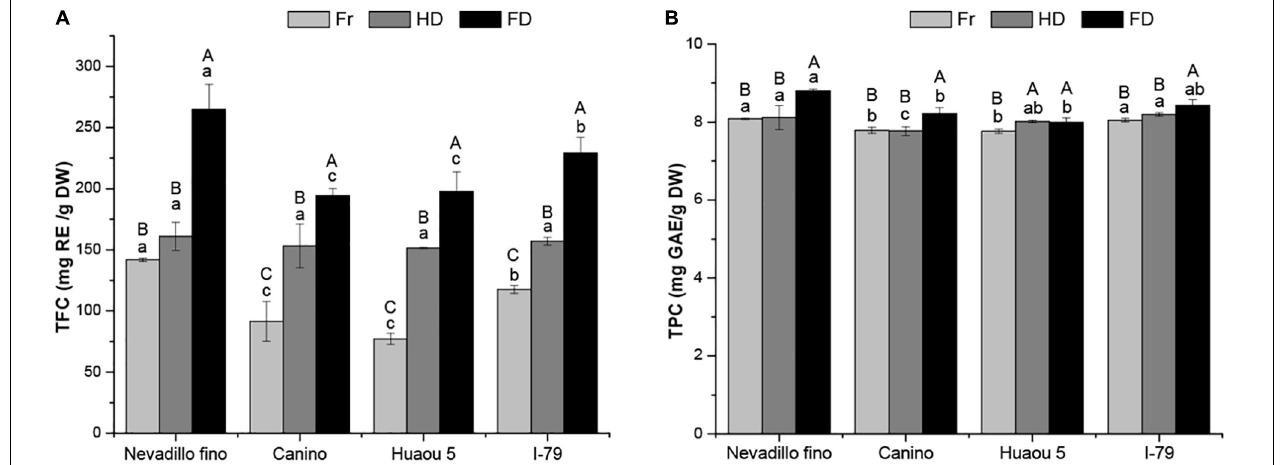
FIGURE 2 | TFC (A) and TPC (B) of dried olive leaves from four cultivars. Fr, HD, and FD denote fresh, hot air-dried, and freeze-dried olive leaf samples, respectively. Data are expressed as mean ± standard deviation ( n = 3). Different letters in the different treatments (A to C) and cultivars (a to c) indicate a significant difference ( P <